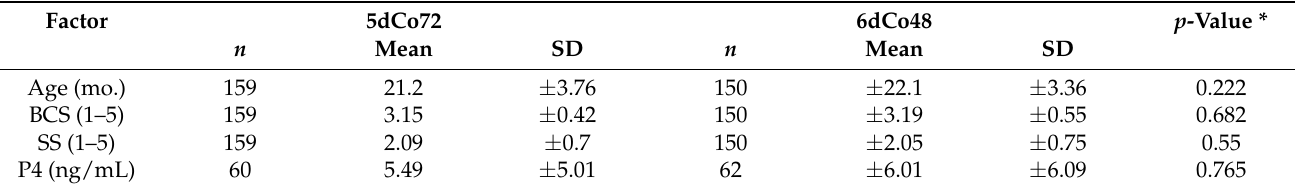
Abbreviations: SD = Standard Deviation; Age: age at study inclusion (Day 0); BCS = Body Condition Score at Day 0, scale 1–5; SS = Stress Score (1–5) at Day 0; P4 = plasma progesterone concentration on Day 0; 5dCo72 = 5d Co-synch 72-h protocol with intravaginal progesterone device (IPD); 6dCo48 = 6-d Co-synch protocol 48-h with IPD. * p -value after Kruskal–Wallis